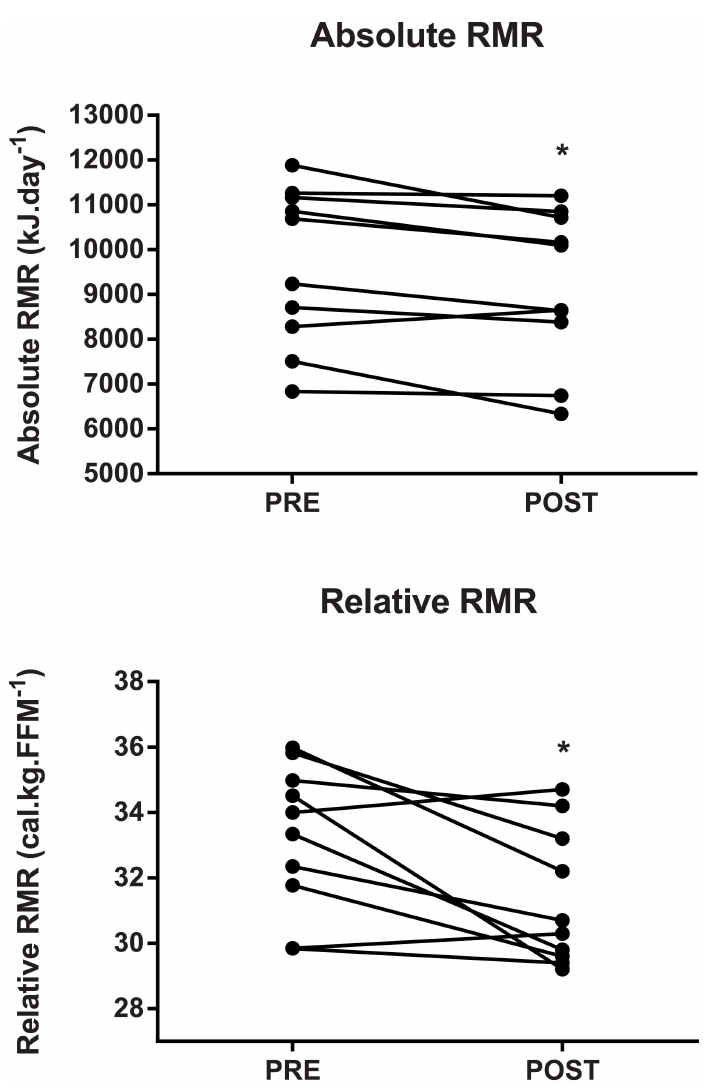
Fig 1. Resting Metabolic Rate (RMR) variables for individual athletes PRE and POST the four-week training cycle. Where a significantdifference betweentime points is observed, * indicatesp < 0.05.